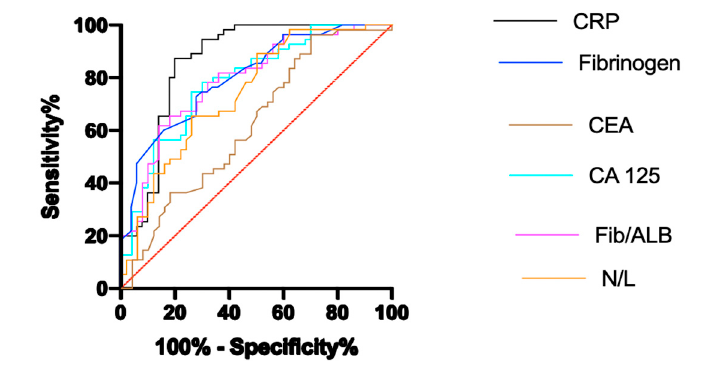
Figure 1. ROC analysis of parameters for breast cancer and IGM.